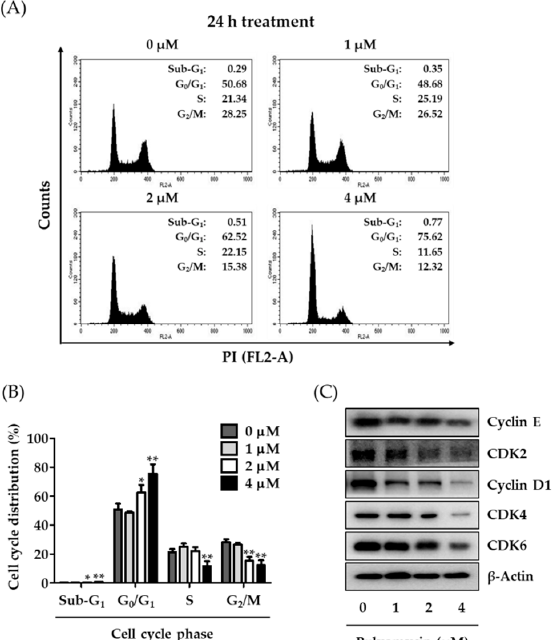
Figure 3. Effects of pulvomycin on cell cycle regulation. ( A , B ) MDA-MB-231-DTR cells were treated with the indicated concentrations of pulvomycin for 24 h and fixed with 70% ethanol for 24 h. Cell cycle distribution was determined in cells incubated with RNase A and PI for 30 min using flow cytometry. Data are presented as the mean ± SD ( n = 3). * p < 0.05 and ** p < 0.01 compared with the control. ( C ) MDA-MB-231-DTR cells were treated with the indicated concentrations of pulvomycin for 24 h, and levels of cyclin E, CDK2, cyclin D1, CDK4, and CDK6 expression were determined using Western blot analysis. β -Actin was used as an internal control.